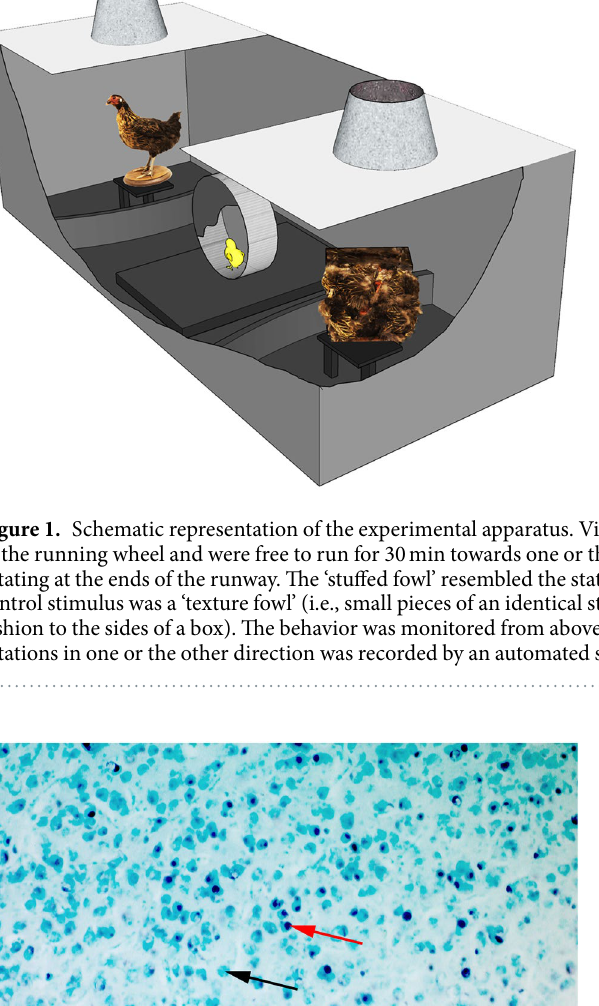
differences between the two groups: t (14) = 1.1930; p = 0.252. All the brains from the ‘stuffed fowl’ (n = 8) and ‘texture fowl’ (n = 8) groups were successfully processed and stained. The brain sections contained high num- bers of c-Fos immunoreactive (c-Fos-ir) cells, which appeared black after the immunohistochemical reaction. Background staining was minimal, thus the c-Fos-ir cells were easily distinguishable from the non-activated cells, which were stained light green due to the methyl-green counterstaining (Fig. 2). We quantified the density of c-Fos-ir neurons in two subdivisions of arcopallium (upper and lower portions of arcopallium), TnA and the three subdivisions of septum (dorsal, ventrolateral, ventromedial), see Fig. 3. Repeated measurements ANOVA revealed a significant interaction of Brain Area * Group : F (2.367;33.131) = 3.149, p = 0.048 (Greenhouse-Geisser cor- rection was applied, because Mauchly test revealed a significant violation of sphericity, p = 0.004), which means that exposure to the ‘stuffed fowl’ or to the ‘texture fowl’ had a different effect on the density of activated c-Fos-ir cells in the different brain areas. Post hoc t-tests revealed significant difference between the two groups in the TnA (t (14) = 2.511; p = 0.025) as well as a non-significant trend in the same direction in the lower portion of (2019) 9:9849 | https://doi.org/10.1038/s41598-019-46322-5